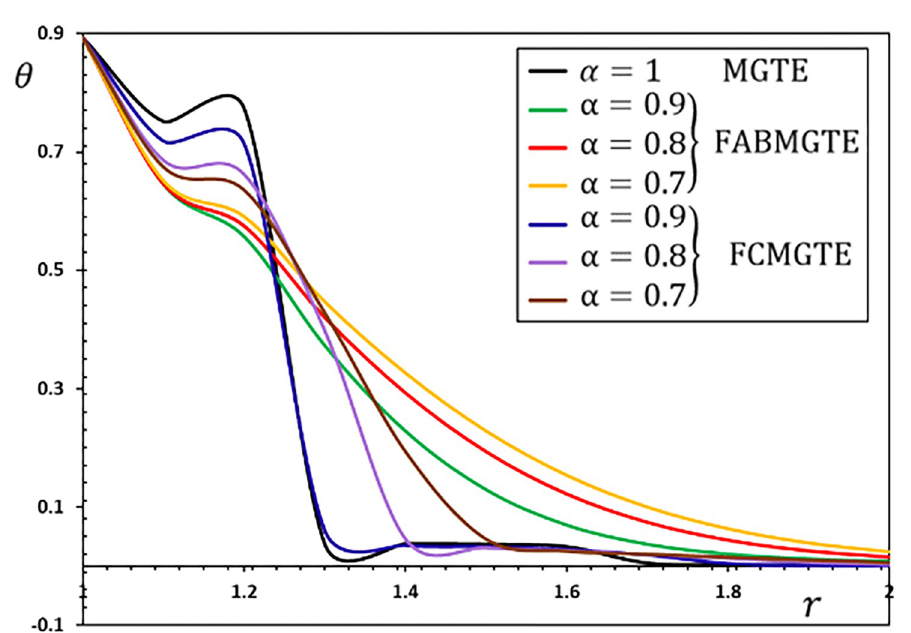
Fig 9. The temperature variation θ for different fractional operator derivatives.